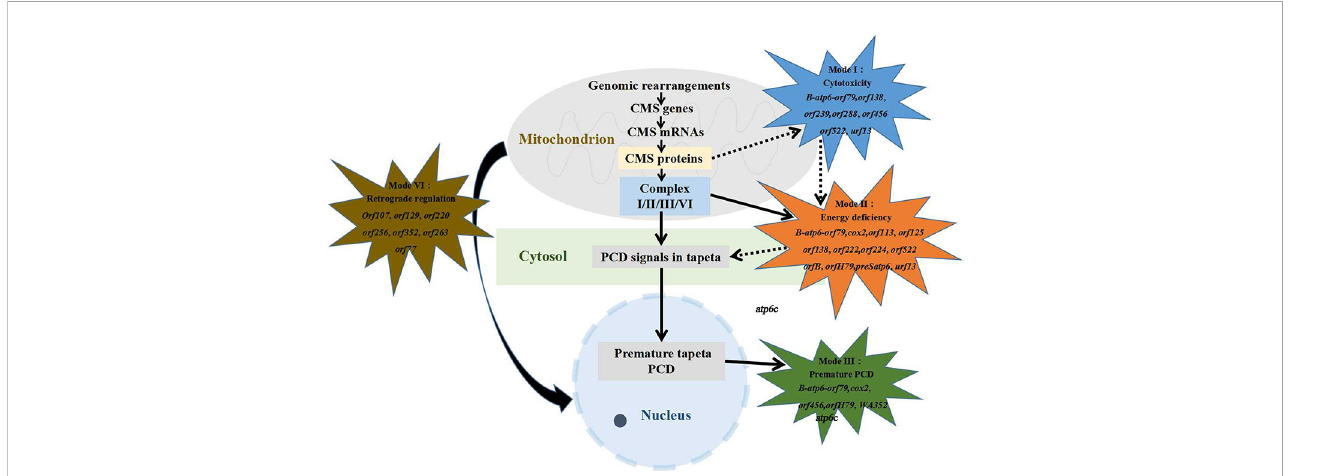
FIGURE 4 Four function mechanisms of cytoplasmic male sterility (CMS) genes. More than 30 mitochondrial genes have been found to participate in CMS formation, with several genes possibly possessing multiple mechanisms of action affecting male sterility. Some of the genes involved in CMS formation have unknown mechanisms. Dotted arrows represent the potential co-action between two